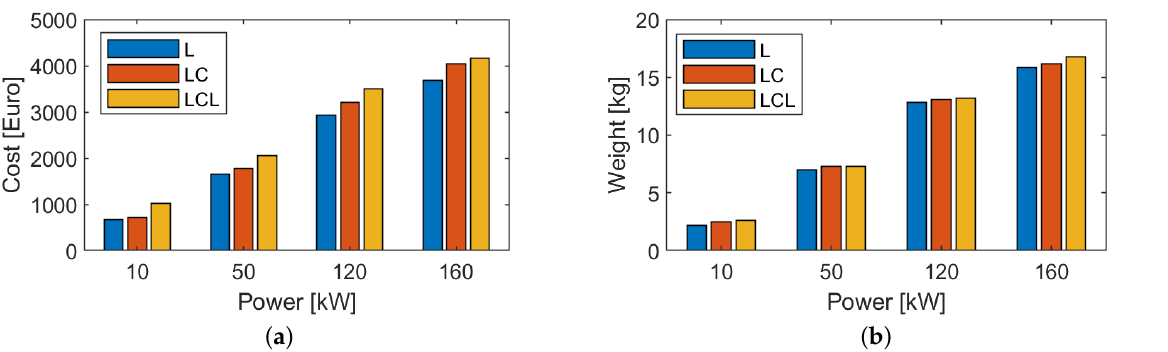
Figure 22. Cost and weight of two-level AFE rectifier with an L/LC/LCL filter. ( a ) Component cost of the filter. ( b ) Weight of the